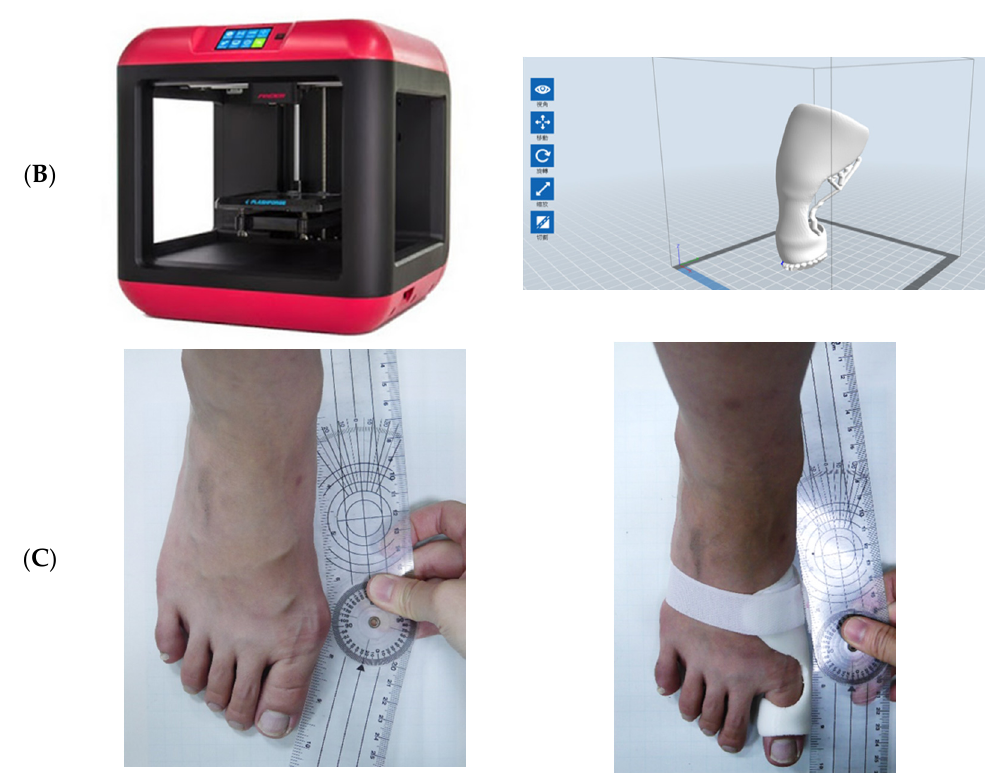
Figure 1. Manufacture of the 3D-printed orthosis: ( A ) Design of the 3D-printed orthosis model. The toe is divided into three parts. The toe part forms a loop shape. The arrows indicate strap and corrective forces. ( B ) 3D-printed orthosis. ( C ) Correction of hallux valgus.